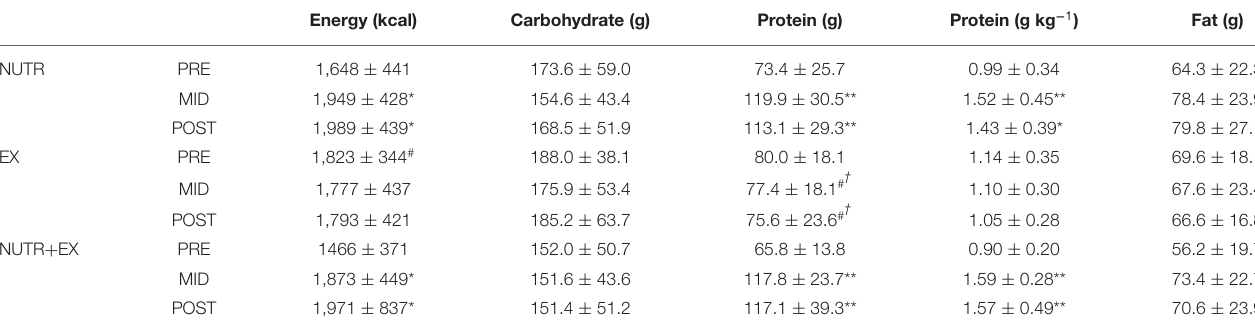
TABLE 2 | Dietary macronutrient intakes during the 12 weeks of concurrent aerobic and resistance exercise training with or without dietary intervention for the respective groups. Energy (kcal) Carbohydrate (g) Protein (g) Protein (g kg − 1 ) Fat (g) NUTR